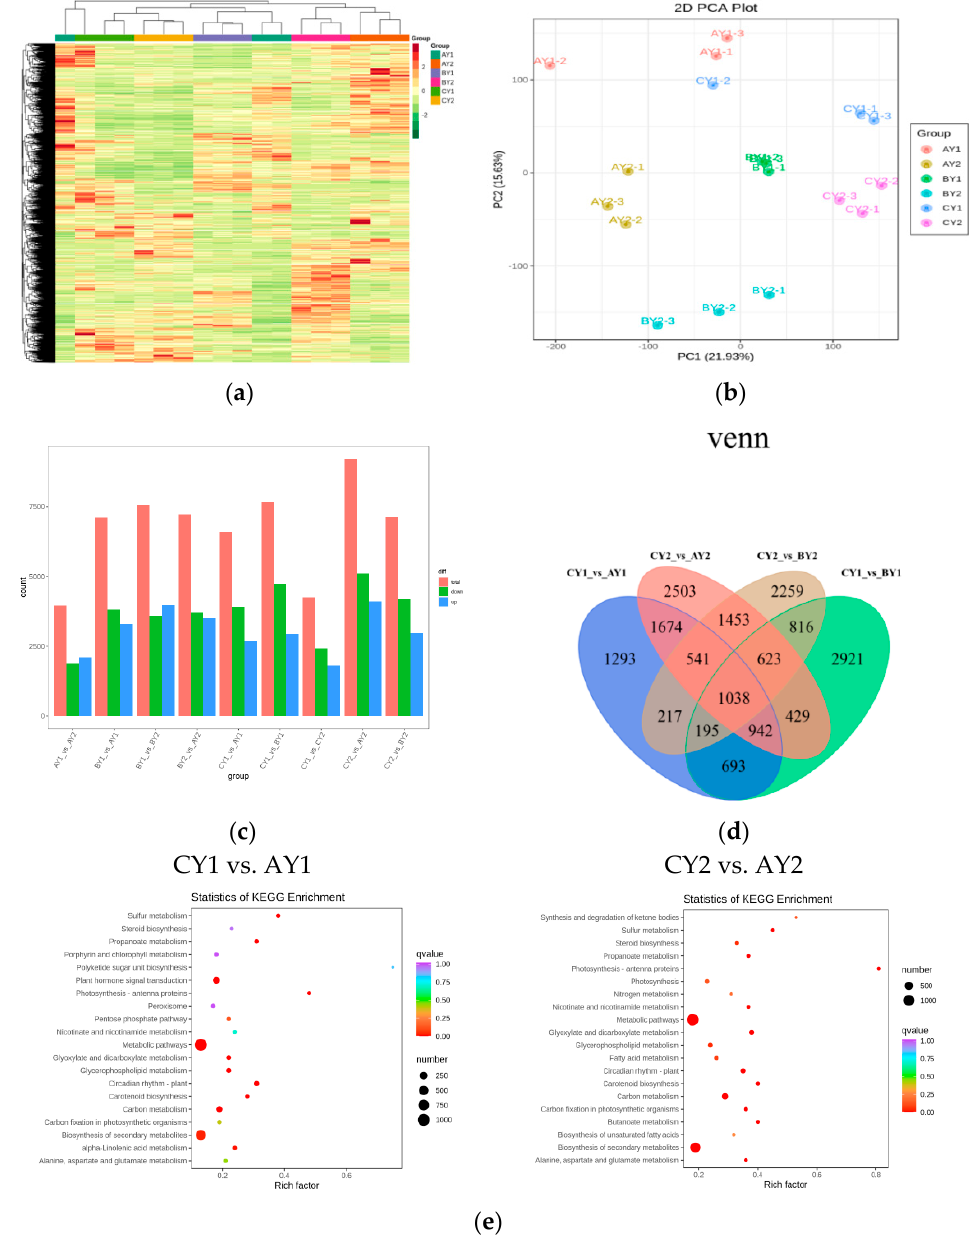
Figure 2. Analysis of transcriptomes differences in quinoa lines under low-temperature stress: ( a ) heat map of differential gene clustering; ( b ) PCA plot of genes; ( c ) statistical map of DEGs; ( d ) Wayne plot of differential genes for low-temperature treatment; ( e ) enrichment scatter plot.